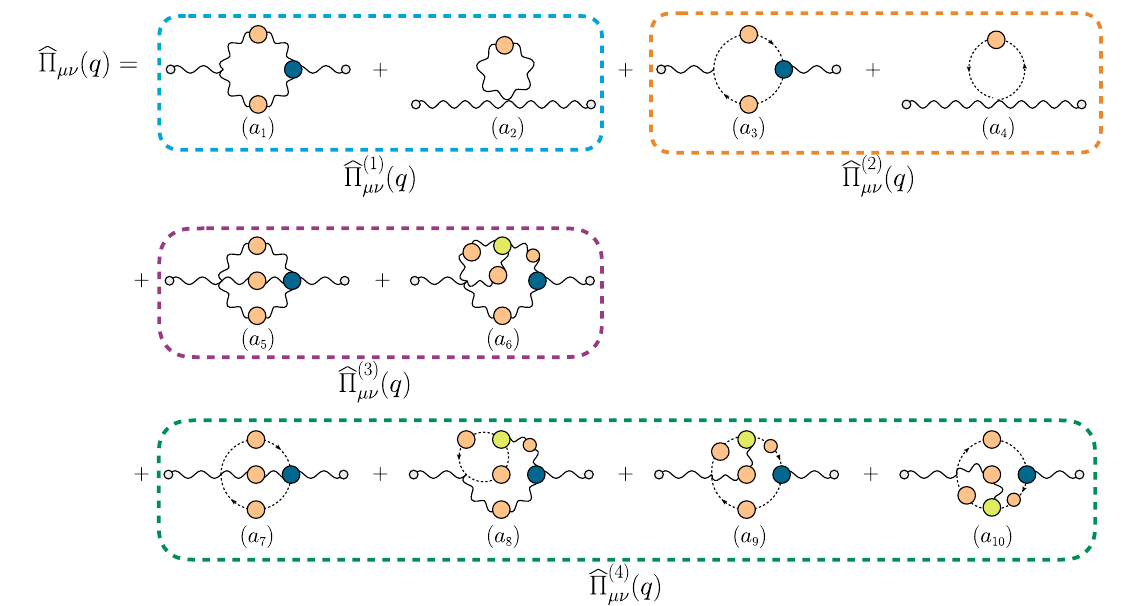
Fig. 1 Diagrammatic representation of the self-energy (cid:2) (cid:3) μν ( q ) . The small gray circles at the end of gluon legs indicate a background field. The orange and green circles represent conventional fully dressed prop-